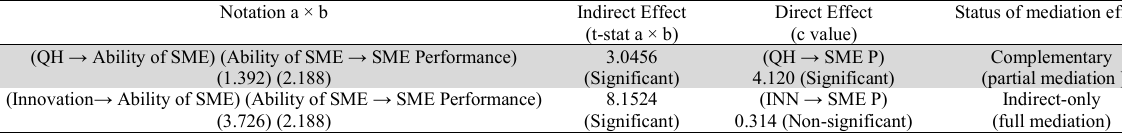
Direct and indirect impact of variables Indonesia craft sub sector Notation a × b